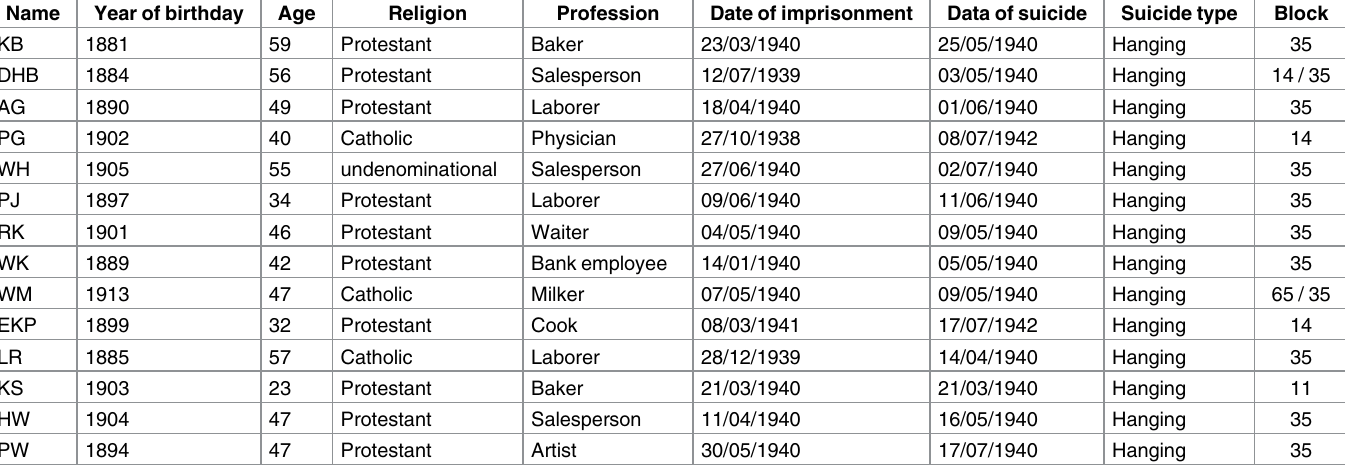
Table 1. Data on suicide cases committed prisoners classified as homosexuals in Sachsenhausen camp.